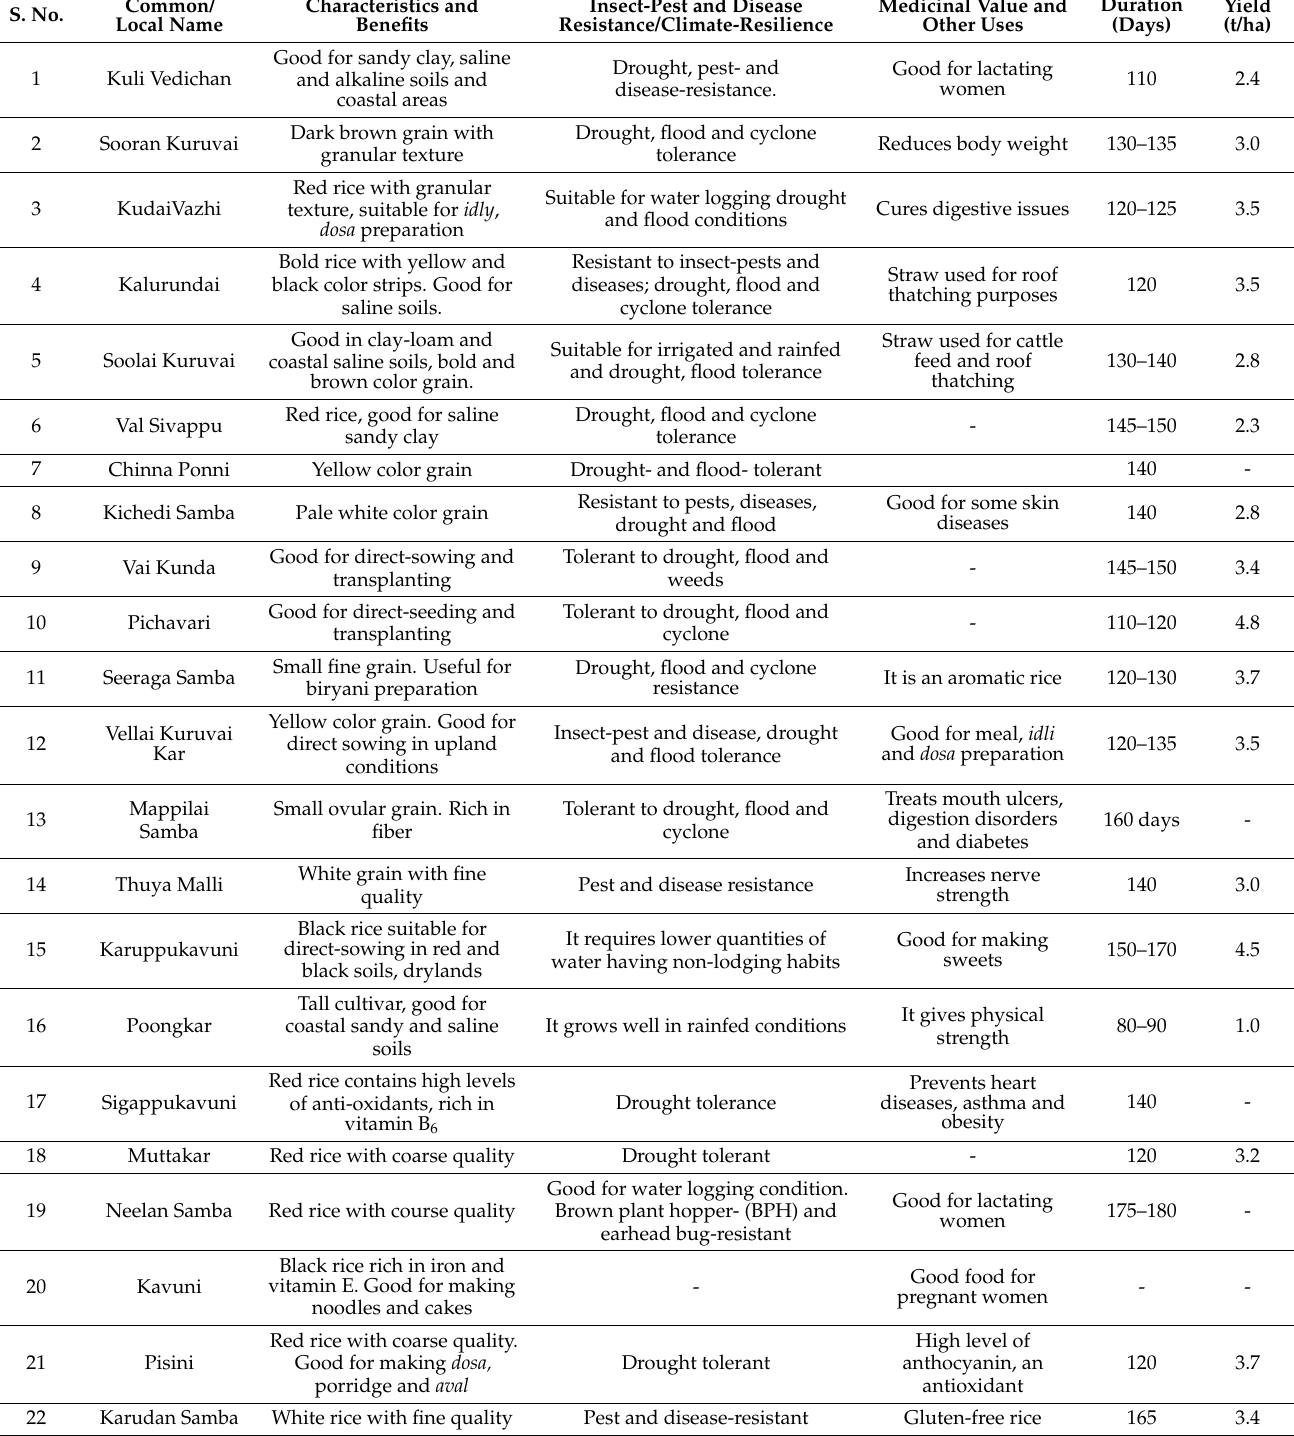
Table 6. Popular Traditional Rice Varieties in Cauvery Delta of the Eastern Coastal